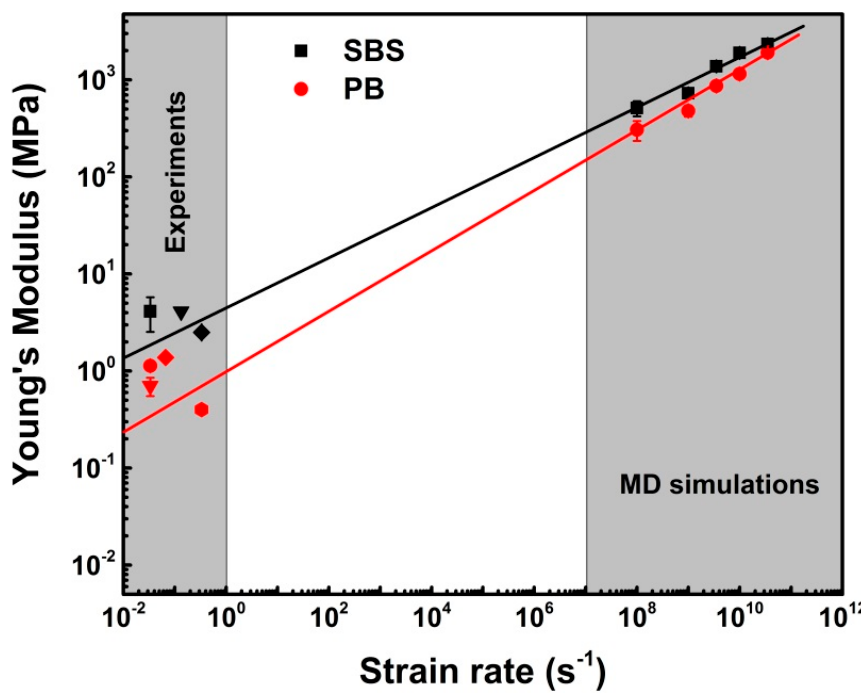
Figure 7. Young’s modulus (experiments and MD simulations) verse strain rate for PB and SBS systems at 300 K and 1 atm. Therein, the solid lines are obtained by fitting the data using Equation (3), and the error bars are associated for different loading conditions to ensure statistical sampling.